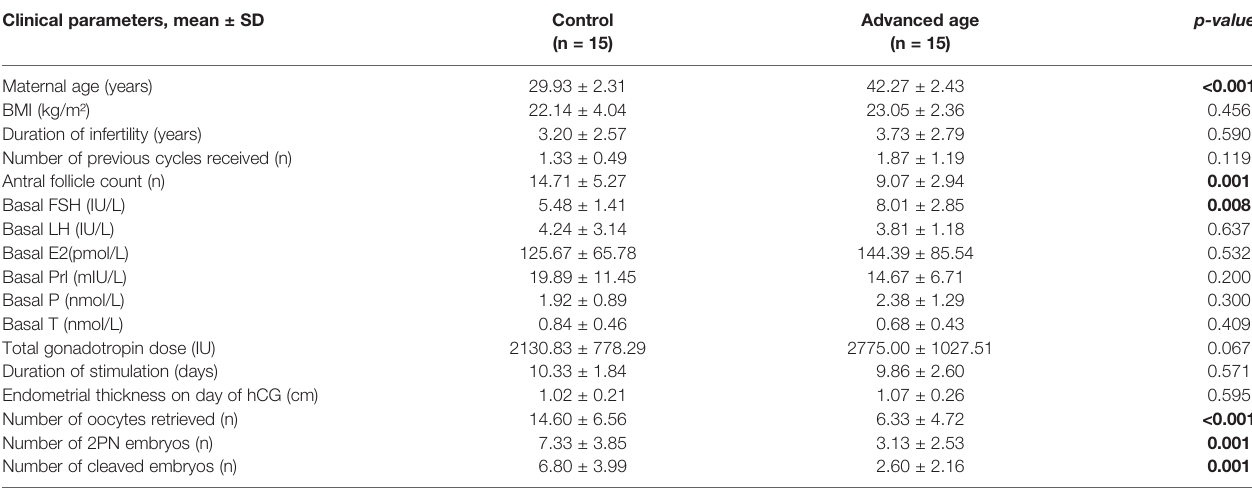
TABLE 1 | Baseline characteristics and ART outcomes of the participants included in the study. Clinical parameters, mean ±